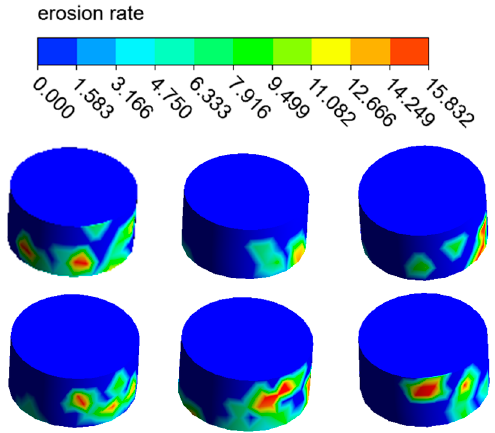
Figure 23. Distribution of the erosion rate on the holes.